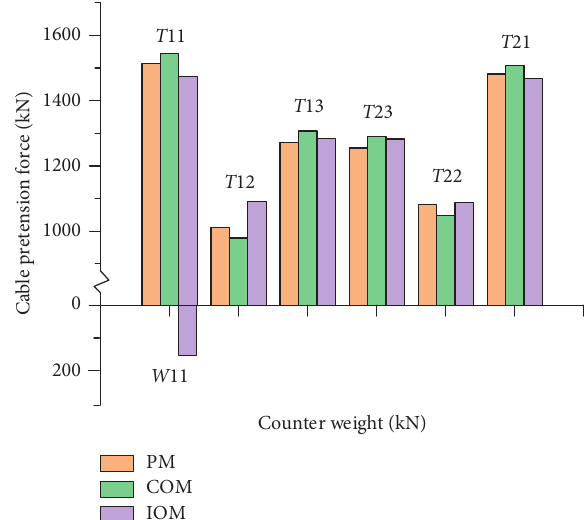
Figure 7: Comparison of design variables of simple cable-stayed bridge model.